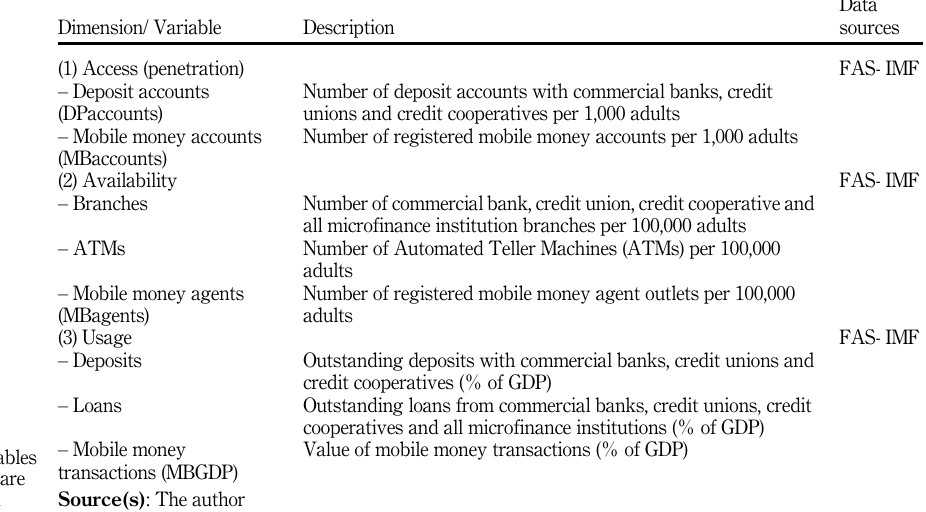
Table 1. Summary of variables and data sources are used in the